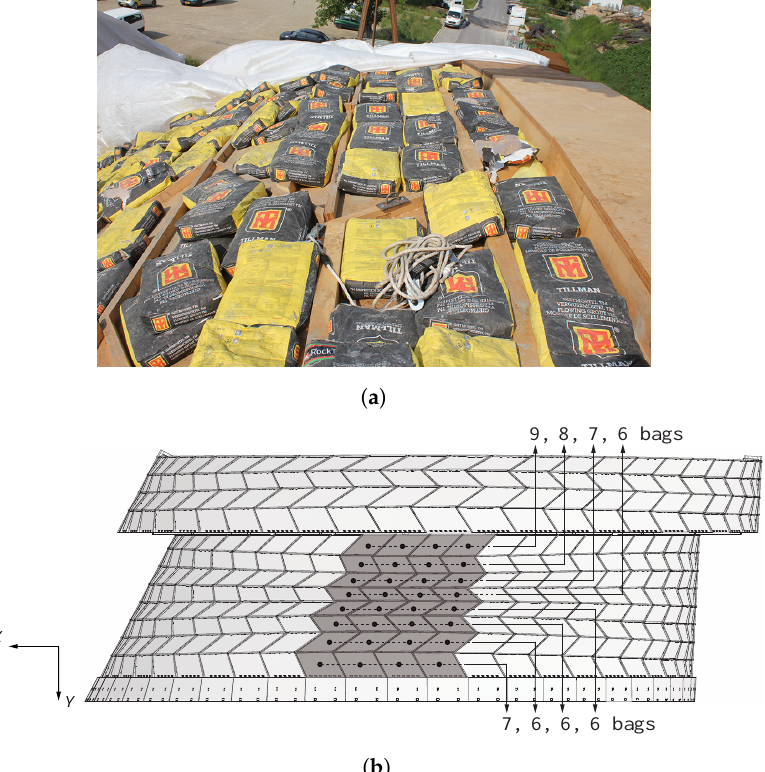
Figure 4. ( a ) Loading of the structure using 25 kg cement bags; ( b ) A distributing loading of 1.5 kN/m 2 in average was applied on the zone of the structure with a lower curvature (grey area). The varying number of cement bags leading to the average load is